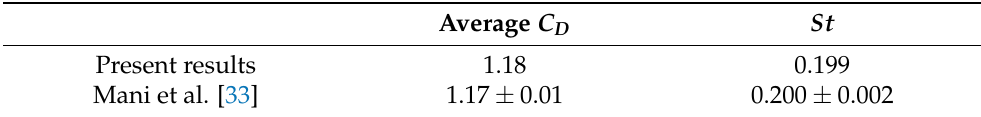
Table 2. Average drag coefficient C D and Strouhal number St for flow over a two-dimensional circular cylinder at Re D =